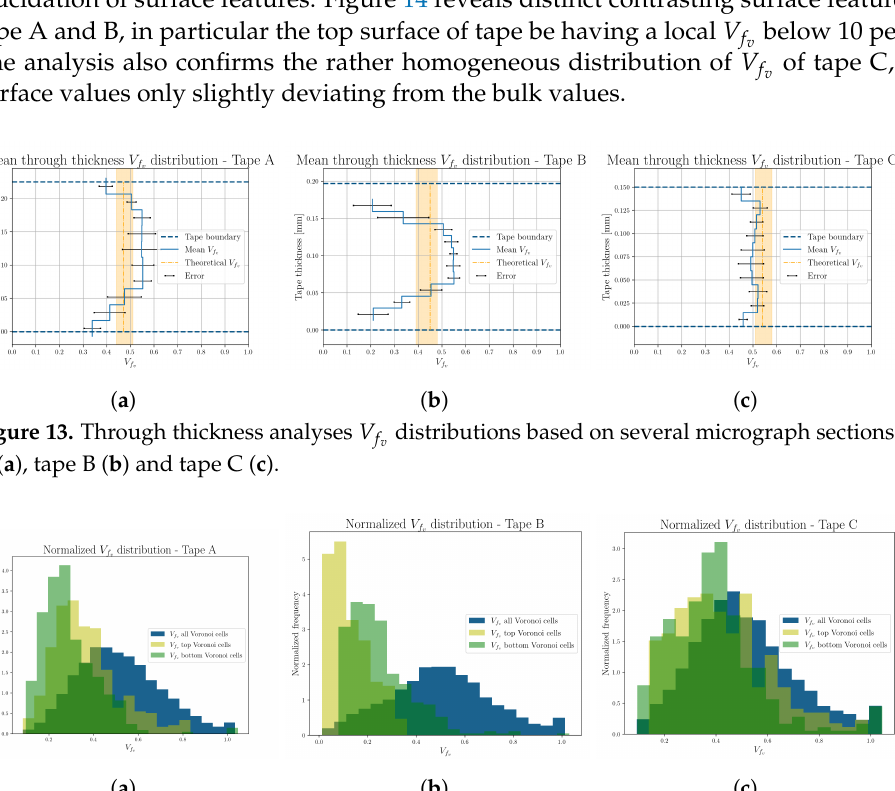
Figure 14. Voronoi analysis of upper and lower boundary, bulk distribution for reference. Tape A ( a ), tape B ( b ) and tape C ( c